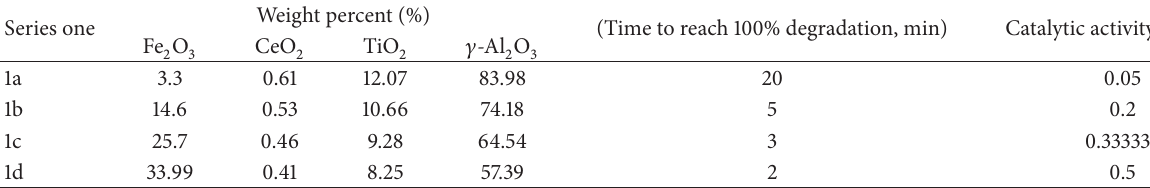
Table 2: Different weight % of oxide form all samples in series 1 and catalytic activity response.